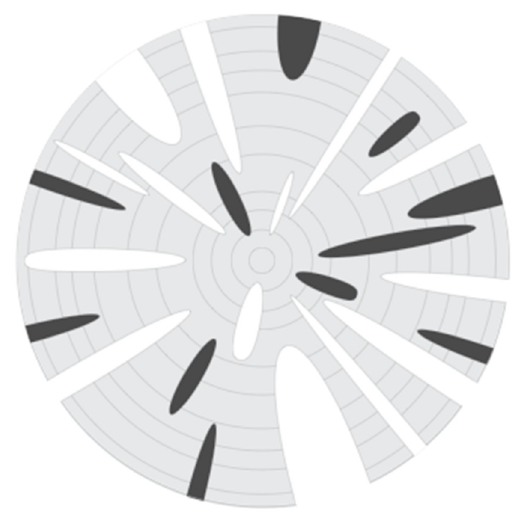
Figure 3. Slicing the sphere of Figure 2 we see that embedded white lacunae and dark-matter aggregations infest, confuse and invalidate part of our academic knowledge.